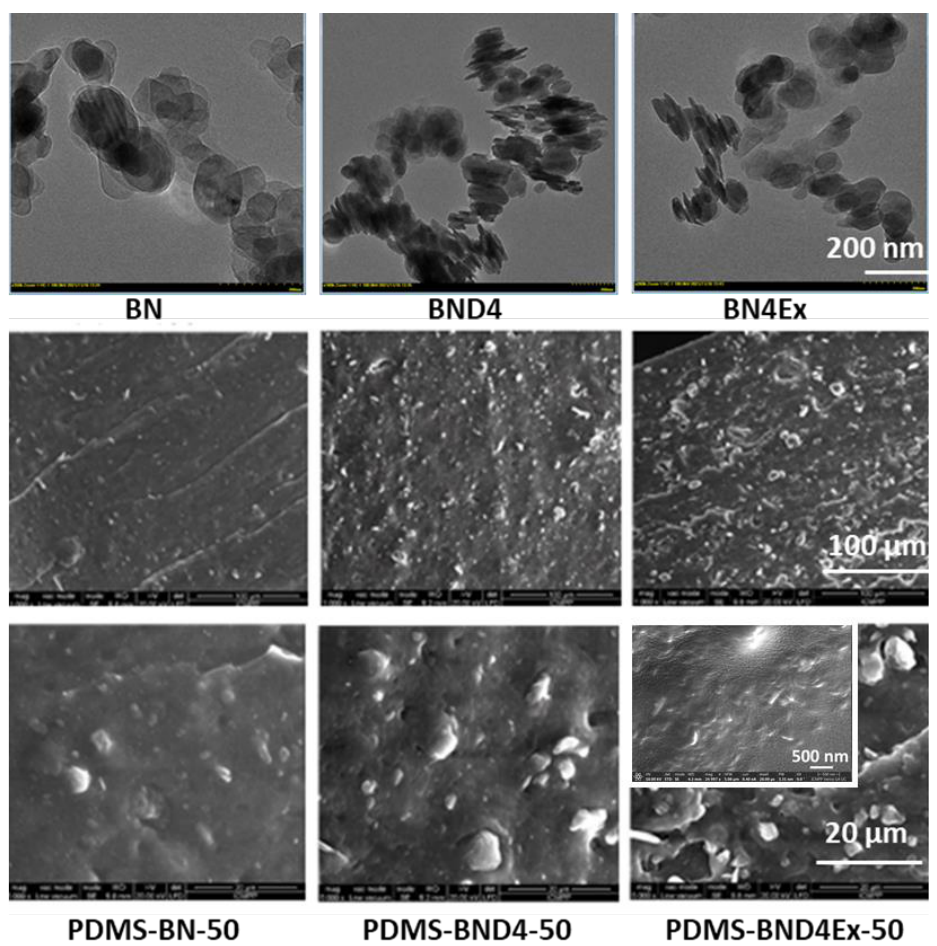
Figure 5. TEM images of the three varieties of BN (top) and SEM images of the derived PDMS-BN composites. The presence of D 4 after hydrophobization (BND4) and exfoliation (BND4Ex) pro- cesses was highlighted by the difference of the spectra (Figure 2a) (subtract spectra func- tion), while the hidden and overlapped peaks of the BN, BND4, and BND4Ex in the 1650 – 830 cm ‒1 were found by using the second derivative of the spectra (Figure 2b). The vertical dashed lines highlight the spectral changes after the applied treatments on BN particles. Thus, the IR spectrum of BN shows two absorption bands, at 1337 cm ‒1 and 762 cm ‒1 , as- signed to the B-N stretches ( h BN). The subtracted IR spectra (subtract BND4 and subtract BND4Ex), consisting on the difference between the BN spectrum and BND4 or BND4Ex spectra, respectively, revealed the presence of the asymmetric and symmetric stretches of C-H bonds (in Si-CH 3 groups) at 2964 and 2922 cm ‒1 , as well as 1258 and 851 cm ‒1 defor- mation, and the stretching vibrations of Si-CH 3 groups and Si-O-Si stretches at 1092 cm ‒1 , proving the hydrophobization of the BN particles, which stretch at 1337 cm ‒1 , is redshifted by 44 – 48 cm ‒1 in the treated and exfoliated samples, due to the distortion of the h BN lat- tices as a result of applied treatments [26]. After the applied treatments of the BN particles, the presence of the isolated OH groups by the band at 3694 cm ‒1 of weak intensity can be observed. The second derivative of the spectra in the 1650 – 830 cm ‒1 spectral region (Figure 2b) evidenced the presence of the absorption maxima characteristic for the h BN crystals, O-H deformation/twisting/wagging vibrations at 1290 cm ‒1 , 980, and 872 cm ‒1 , overlapped